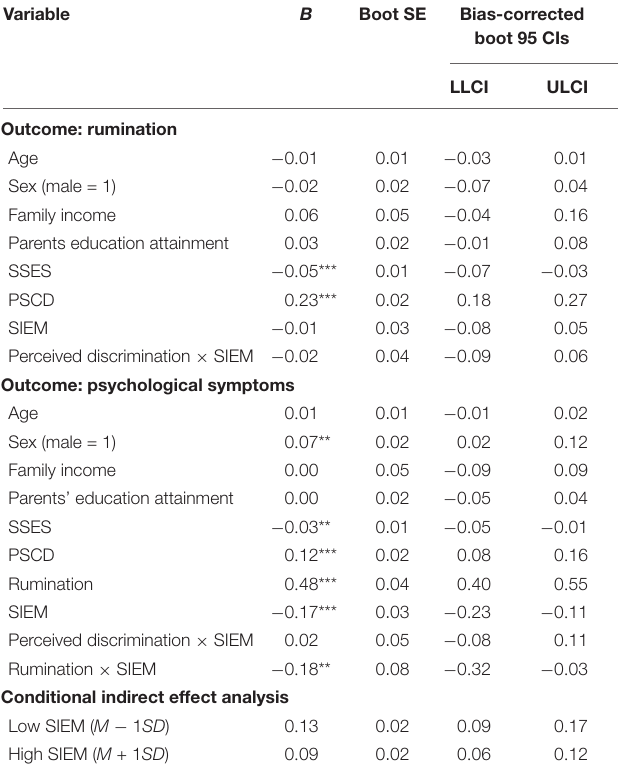
TABLE 3 | The moderated mediation model